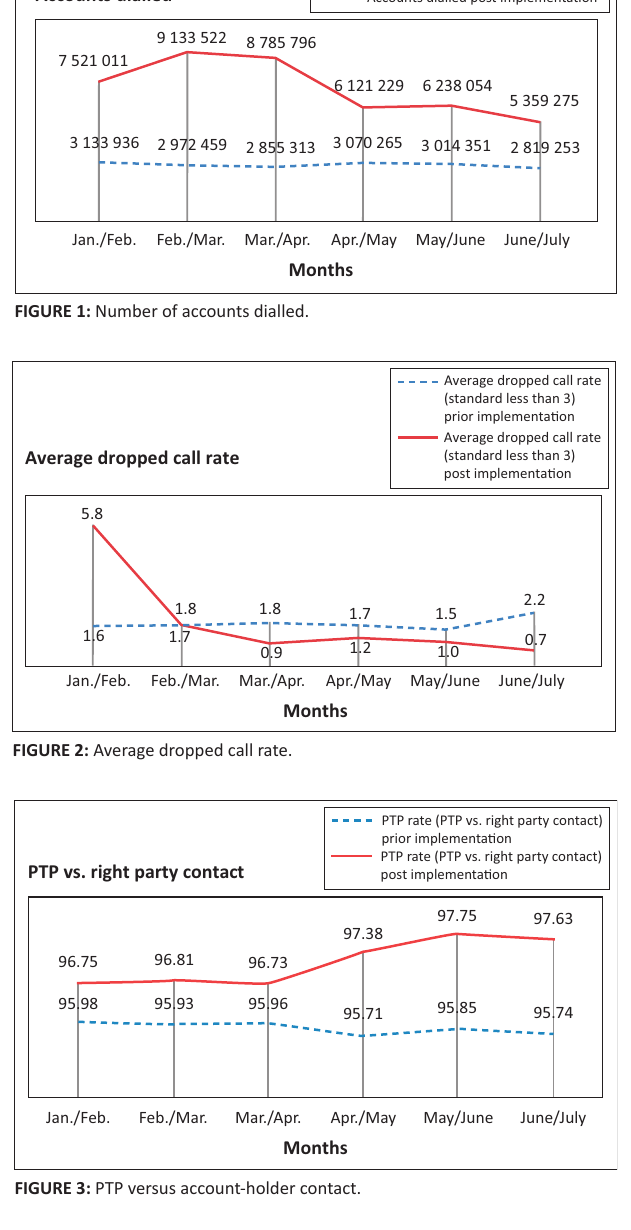
FIGURE 3: PTP versus account-holder